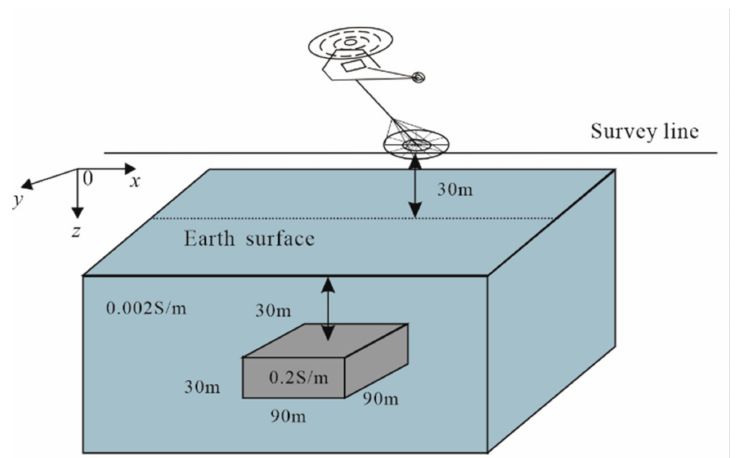
Figure 4. A horizontal plate embedded in a homogeneous half-space.